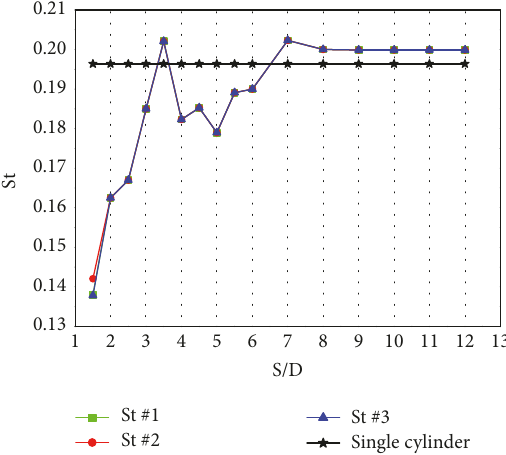
Figure 21: Variations of mean lift coefficients with different spacing distances for three cylinders.